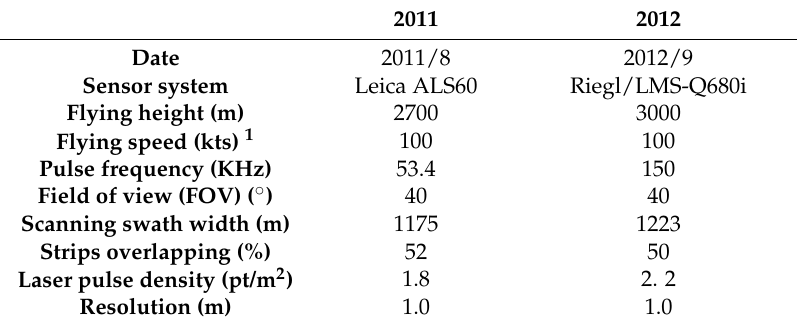
Table 2. Flight parameters and scanning system